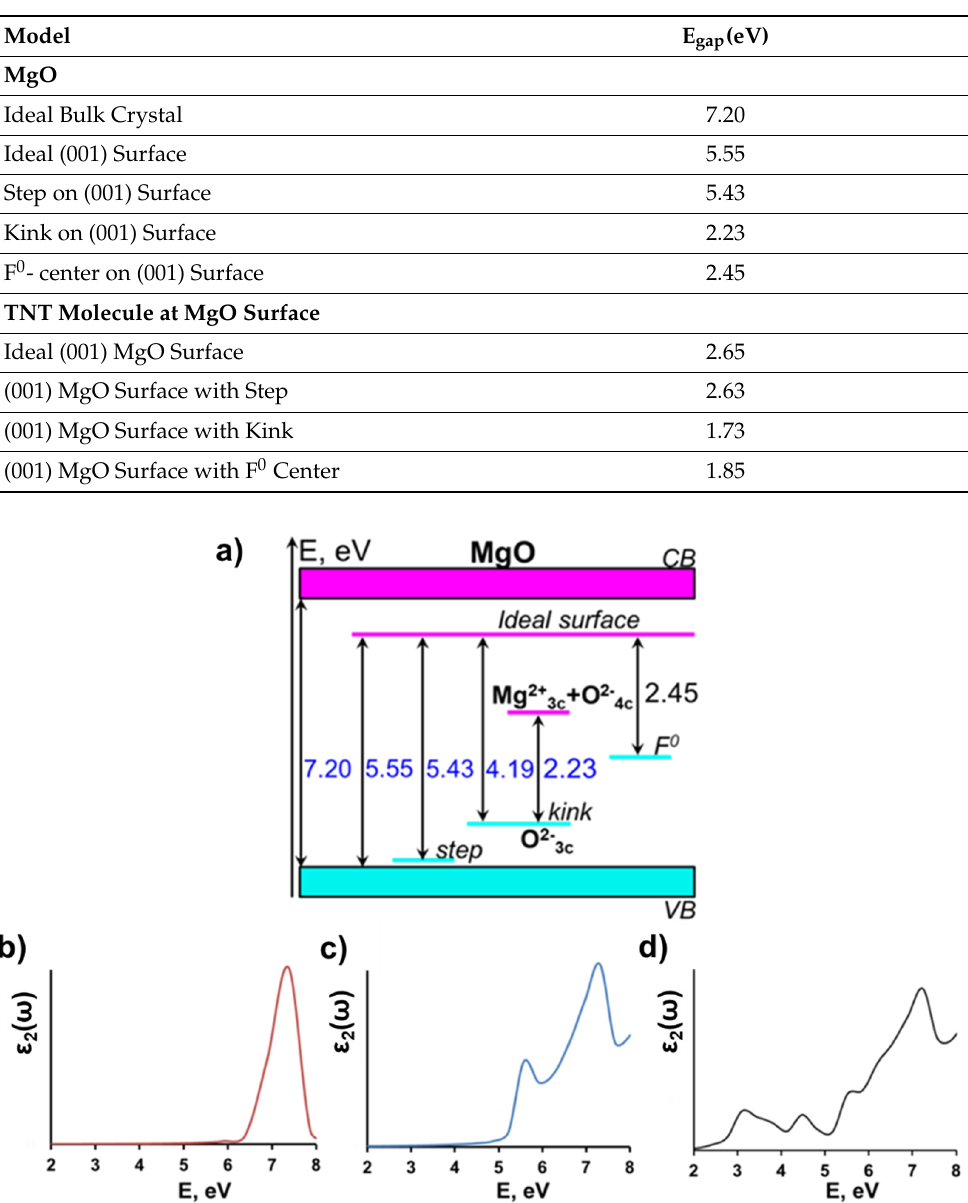
Figure 3. ( a ) A diagram showing the relative energies of local electronic states corresponding to the step, kink, and F 0 -center defects at the MgO (001) surface versus the defect-free bulk and surface magnesium oxide band gaps; the frequency-dependent imaginary part of the dielectric function (averaged over three crystallographic directions) of: ( b ) MgO ideal bulk; ( c ) MgO (001) surface; ( d ) F 0 -center at the MgO (001) surface. ( d ) F 0 -center at the MgO (001)